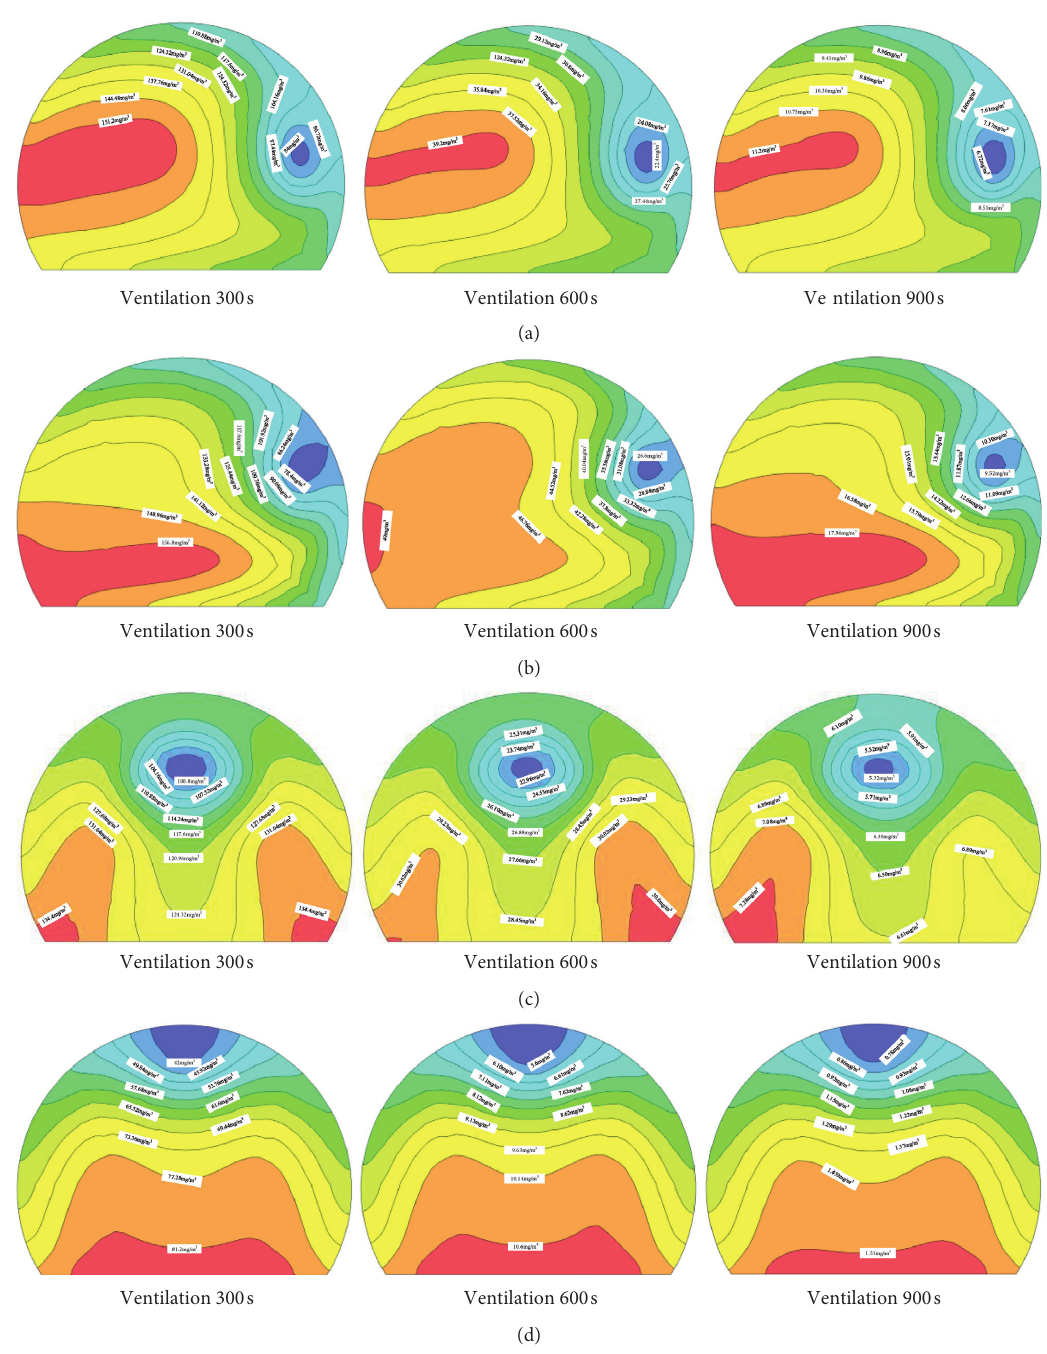
Figure 7: Cloud diagram of CO ventilation diffusion concentration change on the tunnel face after blasting. (a) Corner. (b) Haunch. (c) Center. (d)